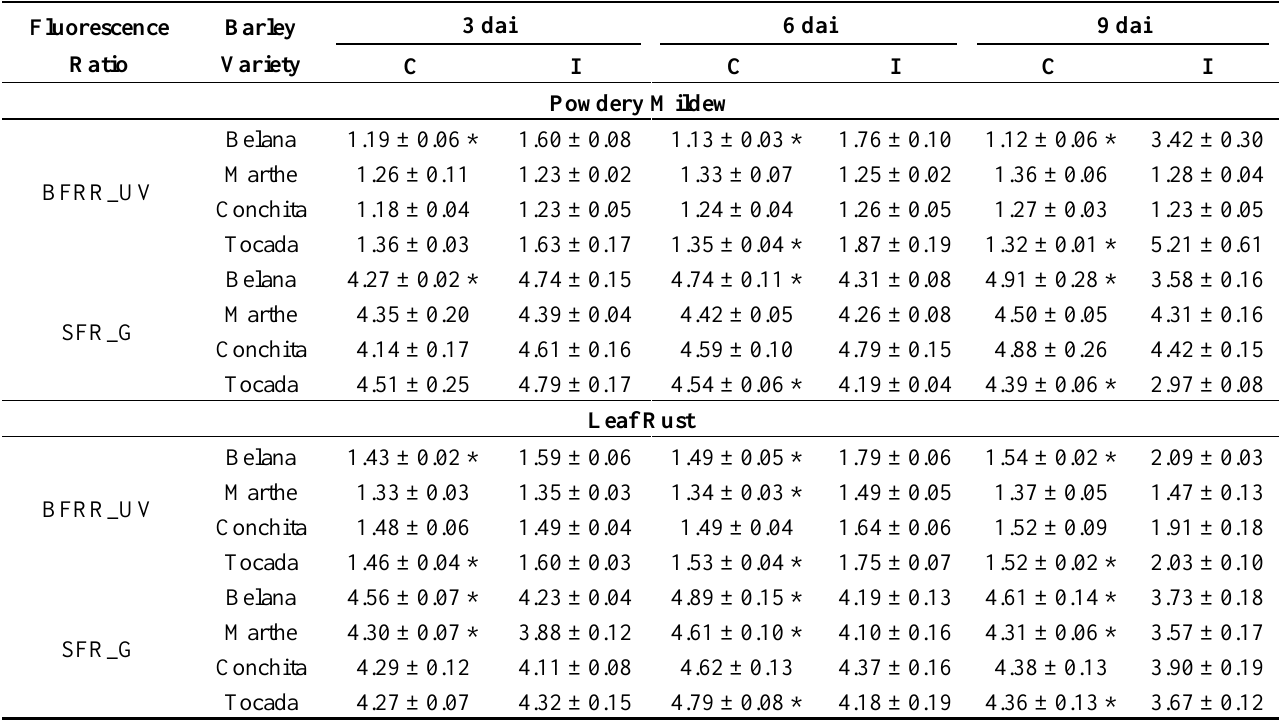
Table 4. Blue-to-far-red fluorescence ratio (BFRR_UV) and „Simple Fluorescence Ratio‟ (SFR_G). The fluorescence signals were recorded from control (C), powdery mildew and leaf rust inoculated (I) leaves of the barley varieties Belana, Marthe, Conchita and Tocada at 3, 6 and 9 days after inoculation